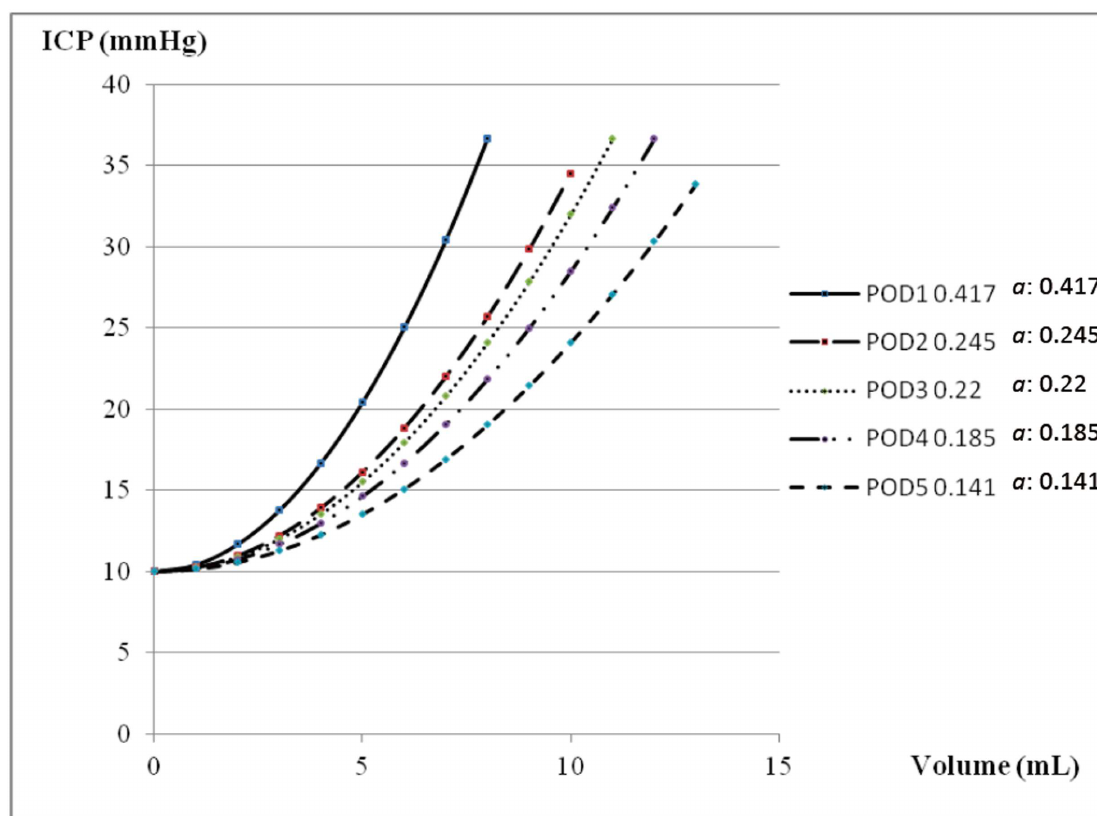
Fig 6. Example of different P-V curves in parabolic regression equations with different indicator “ a ” in one patient from case illustration 2. The steepest P-V curve was derivedfrom POD 1 with an indicator “ a ” of 0.417. From left to right, the P-V curve became more and more flat and the indicator “ a ” in each P-V curves declined from POD 1 to POD 5.